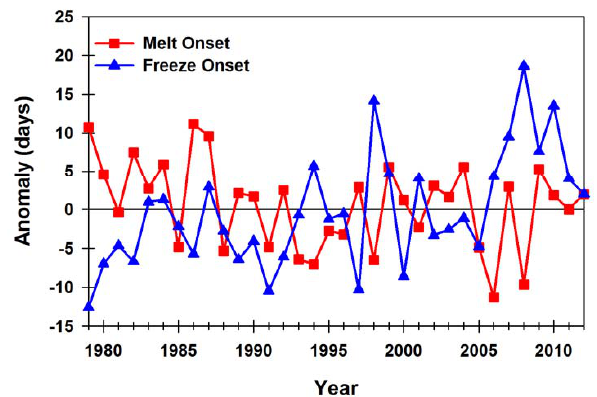
Figure 10. Time series of the melt and freeze onset anomalies (days) in the Canadian Arctic Archipelago, 1979-2012. Anomalies calculated with respect to the 1981-2010 climatology. Fig. 10. Time series of the melt and freeze onset anomalies (days) in the Canadian Arctic Archipelago, 1979–2012. Anomalies calcu- lated with respect to the 1981–2010 climatology.